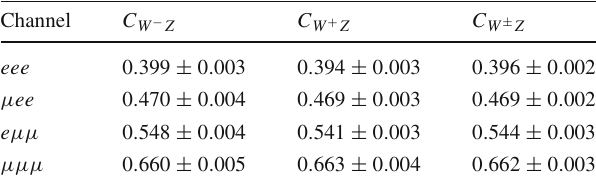
Table 2 The C WZ factors for each of the eee , μ ee , e μμ , and μμμ inclusive channels. The Powheg+Pythia MC event sample with the “resonant shape” lepton assignment algorithm at particle level is used. Only statistical uncertainties are